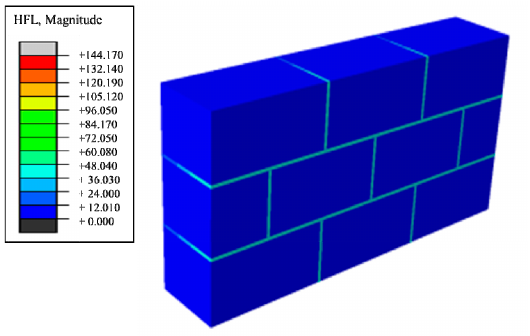
Materials 2019 , 12 , x FOR PEER REVIEW Figure 6. Steady heat transfer temperature nephogram (containing decanoic acid).